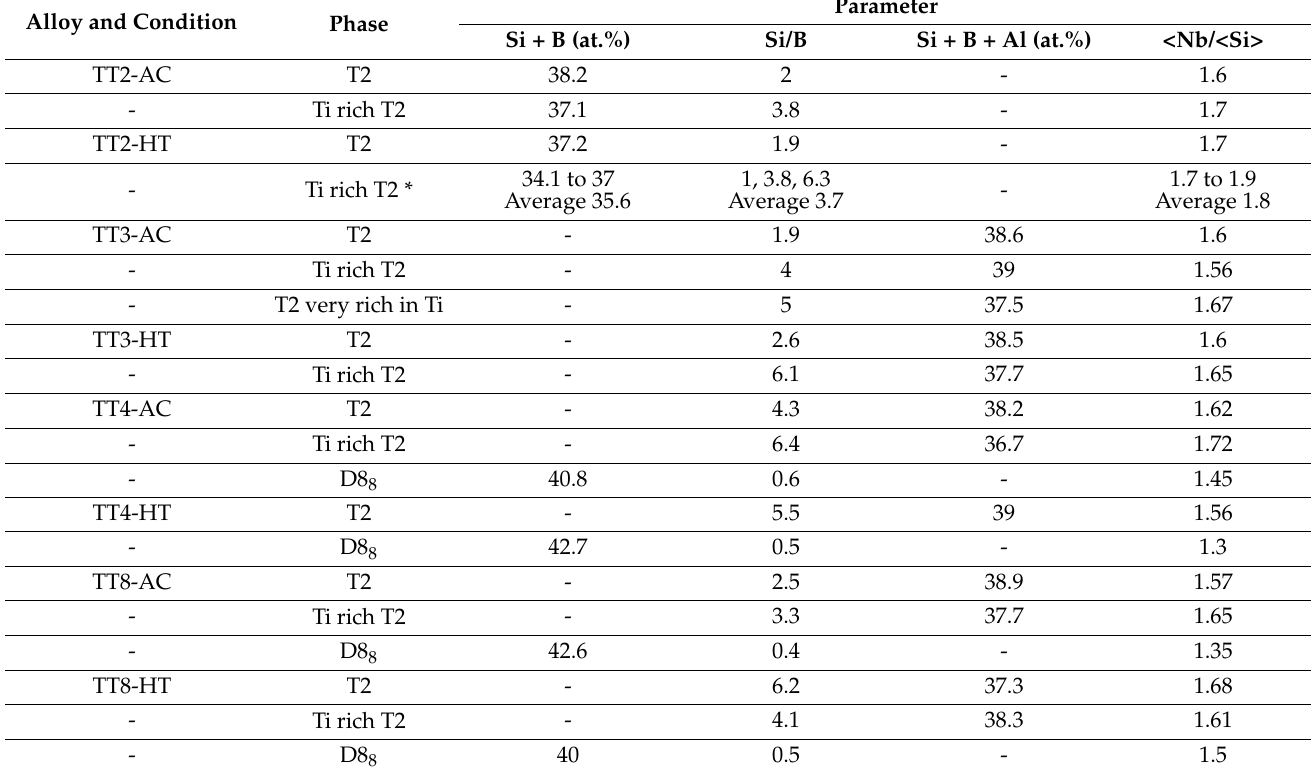
Table A2. <Nb>/<Si> and Si/B ratios and Si + B and Si + B + Al sums in T2 and D88 silicides in AC and HT alloys,